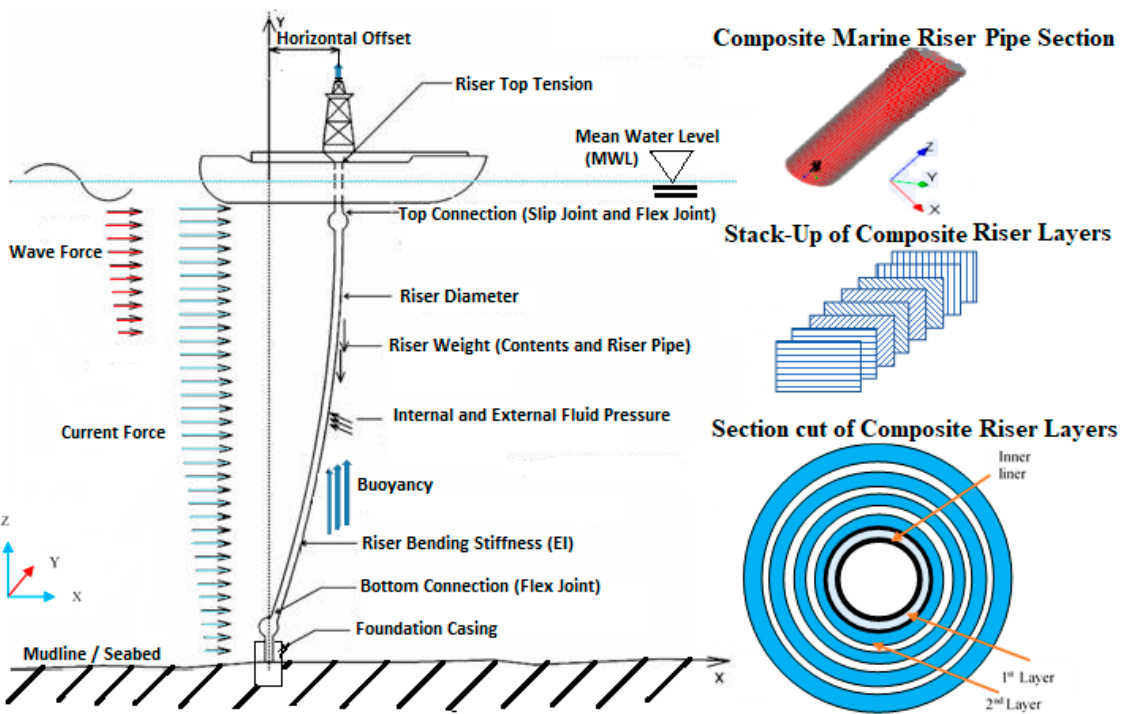
Figure 2. Typical composite riser showing composite stack-up, cross-section, and some loads (not drawn to scale).